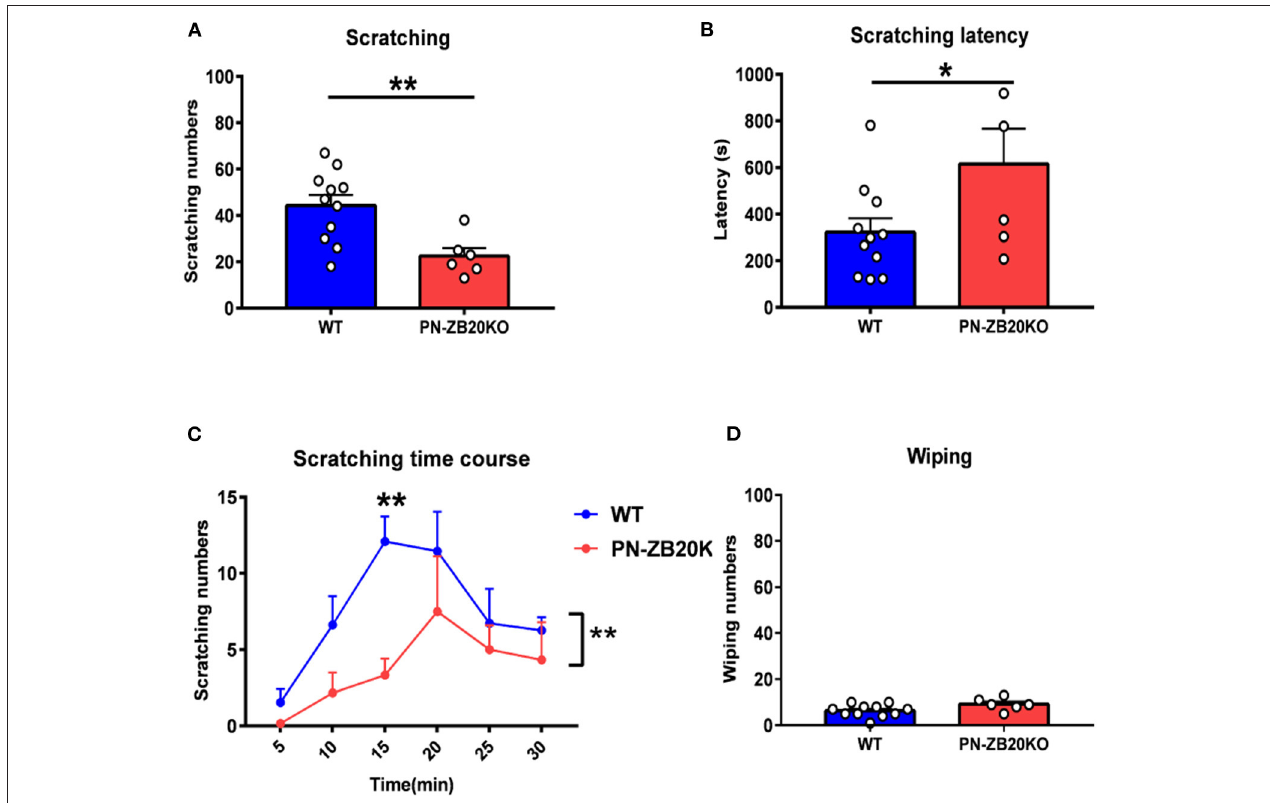
FIGURE 2 | CQ-induced itch was dramatically attenuated in PN-ZB20KO mice. (A) The scratching behavior induced by injection of CQ (40 µ g in 10 µ L PBS) into the mouse cheek was decreased significantly in PN-ZB20KO mice compared to control mice ( t -test, ** p < 0.01). (B) The latency to scratch following CQ injection significantly increased in PN-ZB20KO mice compared to control mice ( t -test, * p < 0.05). (C) The time course of scratching behavior induced by CQ administration. Two-way ANOVA [F (1, 15) = 10.27; p = 0.0059, ** p < 0.01]. (D) The wiping induced by CQ was maintained at a low level and did not change after histamine administration ( t -test, p > 0.05). N = 6–11 for each